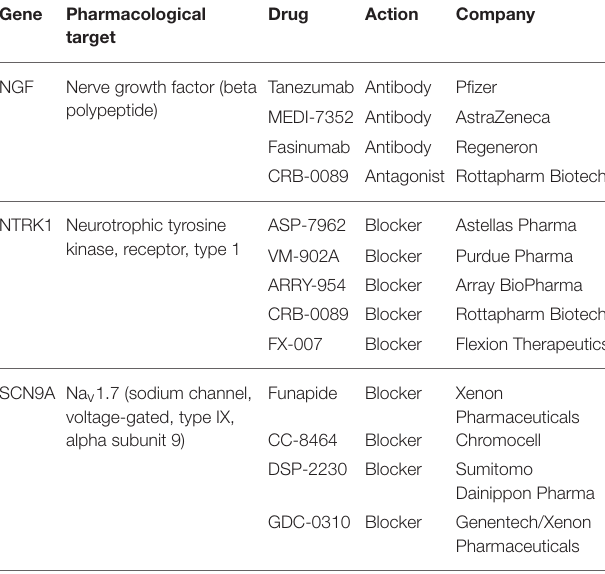
TABLE 2 | Novel analgesic drugs developed with the purpose to antagonistically target genes associated with human hereditary insensitivity to pain, i.e., to mimic the pain-insensitivity phenotype observed in carriers of loss-of-function mutations in these genes, being currently in a clinical phase of development according to publicly available sources of information ( Table 3